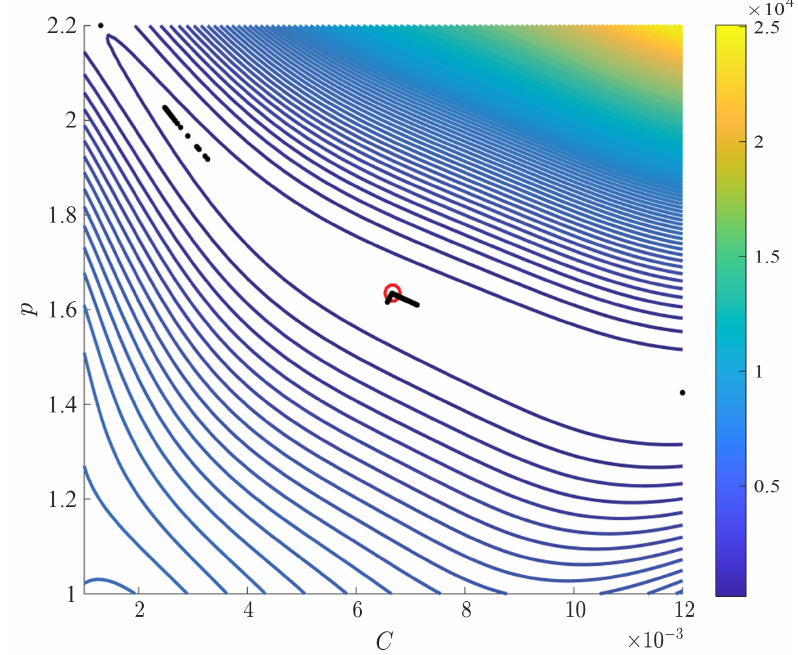
Figure 17. Contours of residuals between predictions and the measurements with constitutive parameter estimates found by the L -curve